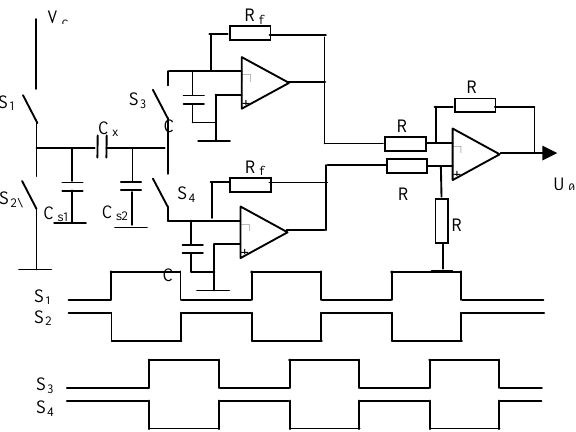
Figure 3. Measuring circuit and switching wave forms, with stray capacitances shown (Cs1, Cs2). To measure the unknown capacitance Cx, two square-wave signals are applied to two complementary metal-oxide-semiconductor (CMOS) switches (CD4066), S1 and S2, so that the left side of Cx is connected either to Vc or earth. The other two square-wave signals are used to control the other two CMOS switches, S3 and